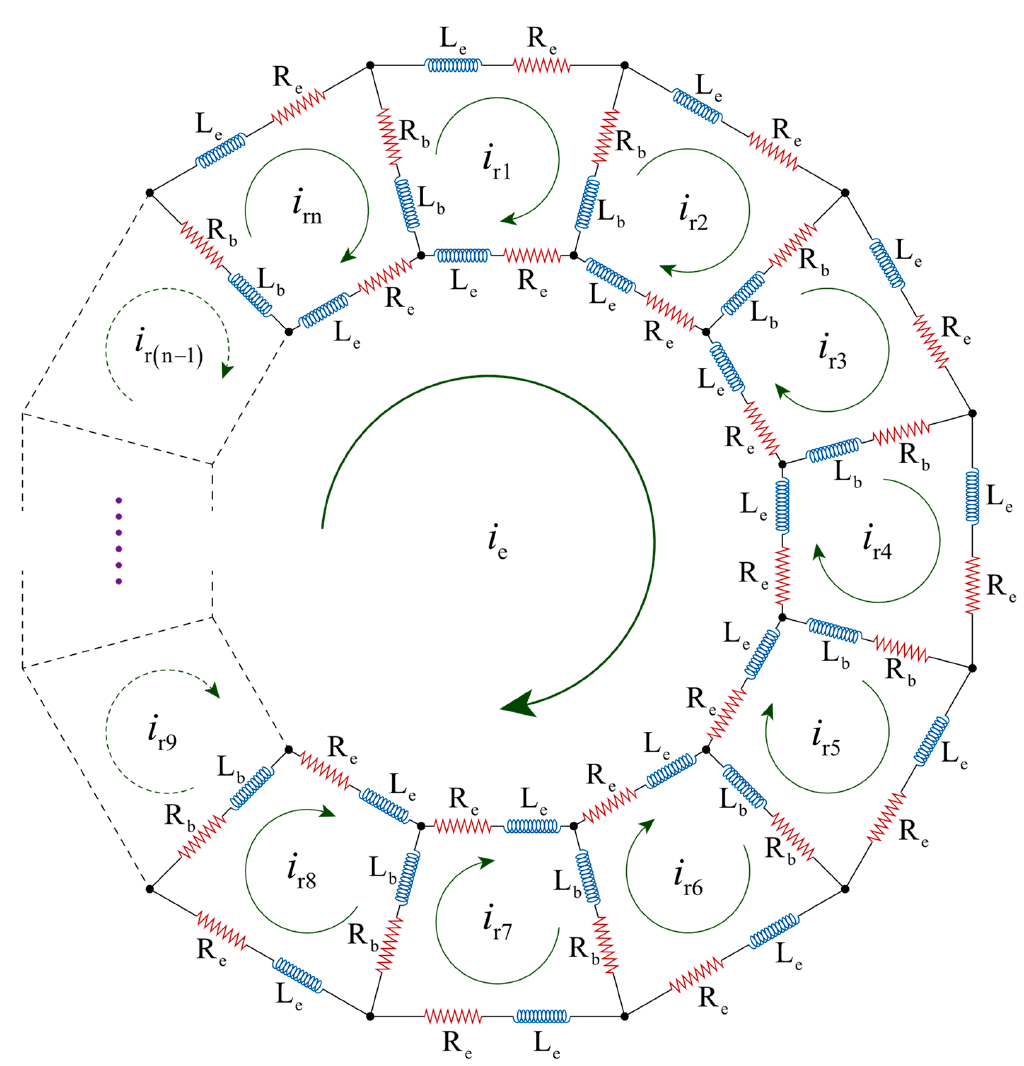
Figure 4. Rotor multiple coupled circuit model.